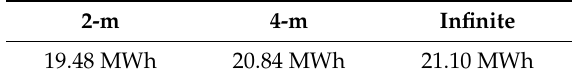
Table 3. The annual energy production at test Site 6 with three different stroke length